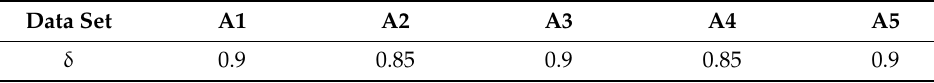
Table 5. Threshold of case similarity.